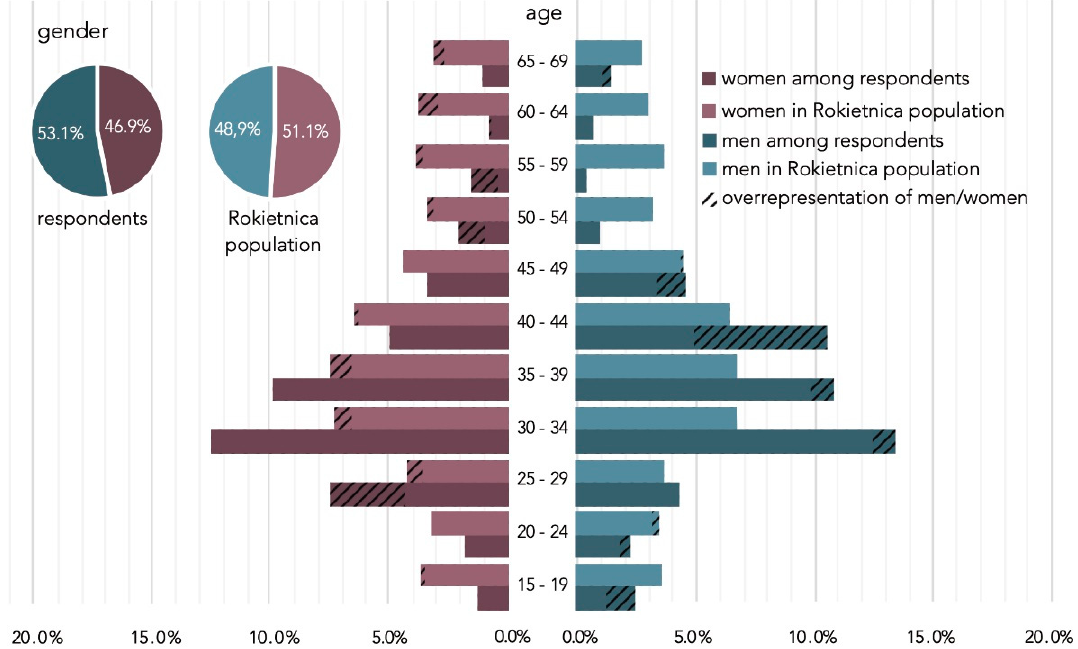
Figure 4. Age and gender structure of respondents in Rokietnica commune. Source: own elaboration based on geo-questionnaire results and statistics Poland data.